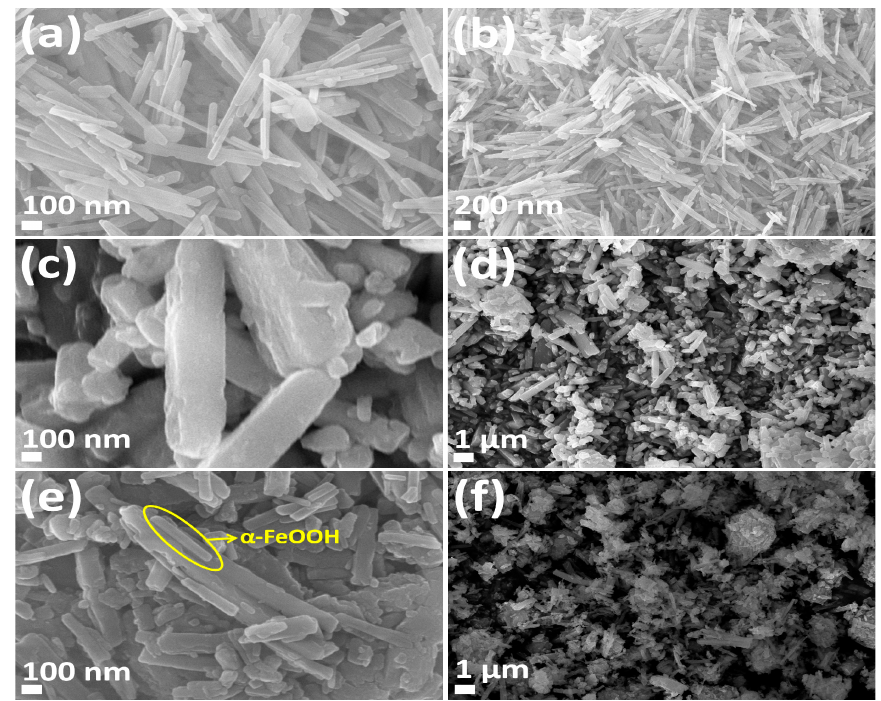
Figure 4. Scanning electron microscopy (SEM) images of ( a , b ) pure α -FeOOH, ( c , d ) pure α -AgVO 3 and ( e , f ) optimized FeAVO-3 nanocomposite photocatalysts at different magnification.